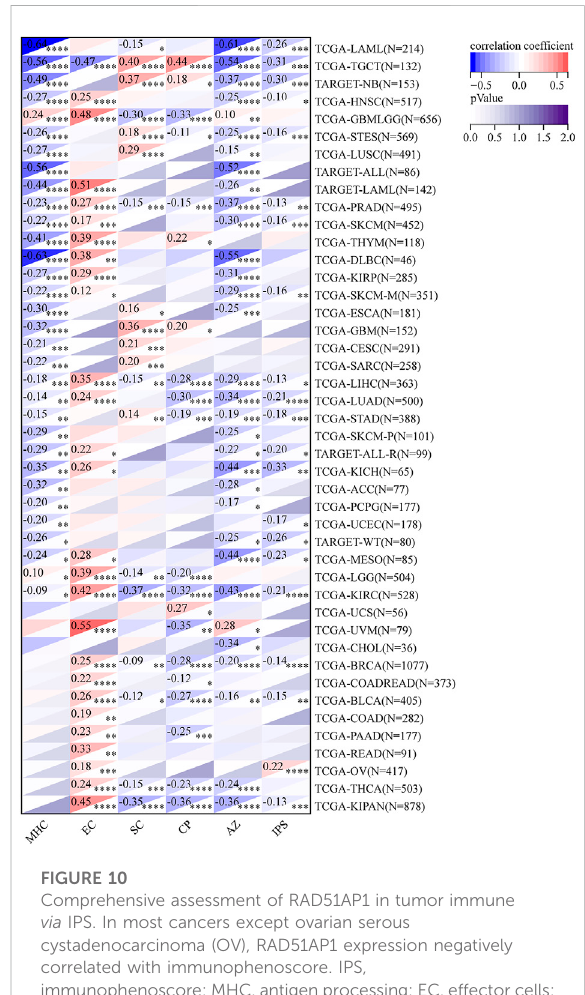
FIGURE 10 Comprehensive assessment of RAD51AP1 in tumor immune via IPS. In most cancers except ovarian serous cystadenocarcinoma (OV), RAD51AP1 expression negatively correlated with immunophenoscore. IPS, immunophenoscore; MHC, antigen processing; EC, effector cells; SC, suppressor cells; CP,